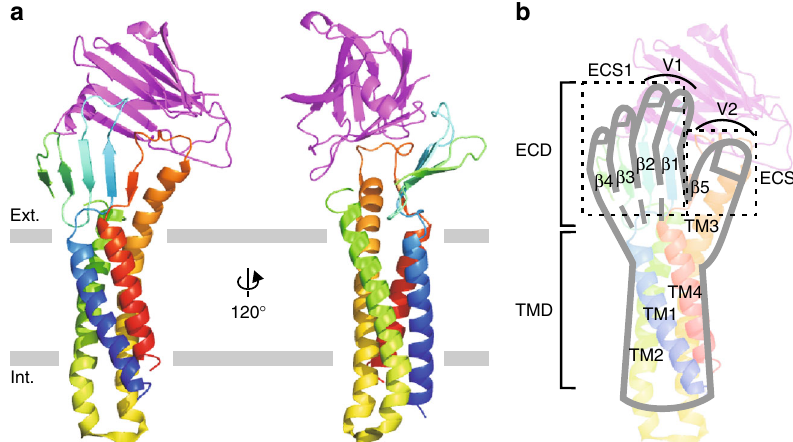
Fig. 1 Structure of mCldn3 in complex with C-CPE. a Overall structure of the mCldn3 cryst /C-CPE complex in ribbon representation viewed parallel to the cell membrane. mCldn3 cryst in rainbow colors from the N terminus (blue) to the C-terminus (red). C-CPE is colored magenta. Gray bars suggest boundaries of outer (Ext.) and inner (Int.) lea fl ets of the lipid bilayer. b Left-hand model of the mCldn3